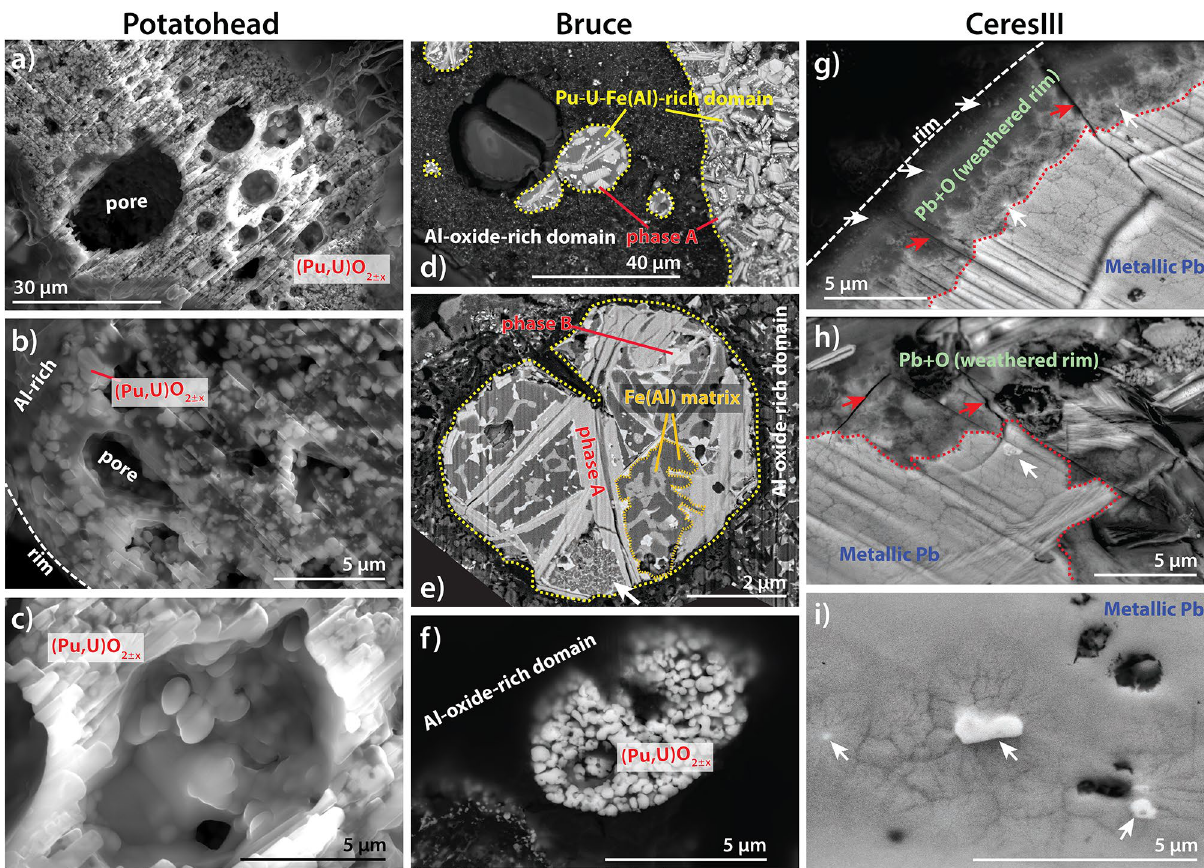
Figure 3. Imaging (BSE mode) of fresh FIB cut surfaces within the hot particles Potatohead , Bruce and CeresIII . Domains and phases are labelled based on EDS spot analyses and maps. ( a ) Popcorn-like texture of (Pu,U)O 2±x phase(s) and pores due to gas entrapment. ( b ) Nano-sized (Pu,U)O 2±x particles in an Al-oxide-rich matrix on the edge of the particle. ( c ) Detail showing absence of weathering product within a pore. ( d ) Textures suggestive of coexistence of Al-oxide-rich and Pu–U-Fe(Al)-rich melts. ( e ) Detail of Pu–U-Fe(Al)-rich aggregate. ( f ) Small aggregate of (Pu,U)O 2±x nano-crystals. ( g ) Rim of the particle, showing oxidation of the metallic lead. ( h ) Detail of the weathering rim. Arrows in ( g , h ) indicate Pu-rich micro- to nano-particles. ( i ) Fracturing around Pu-carbide inclusions (white) resulting from radiation